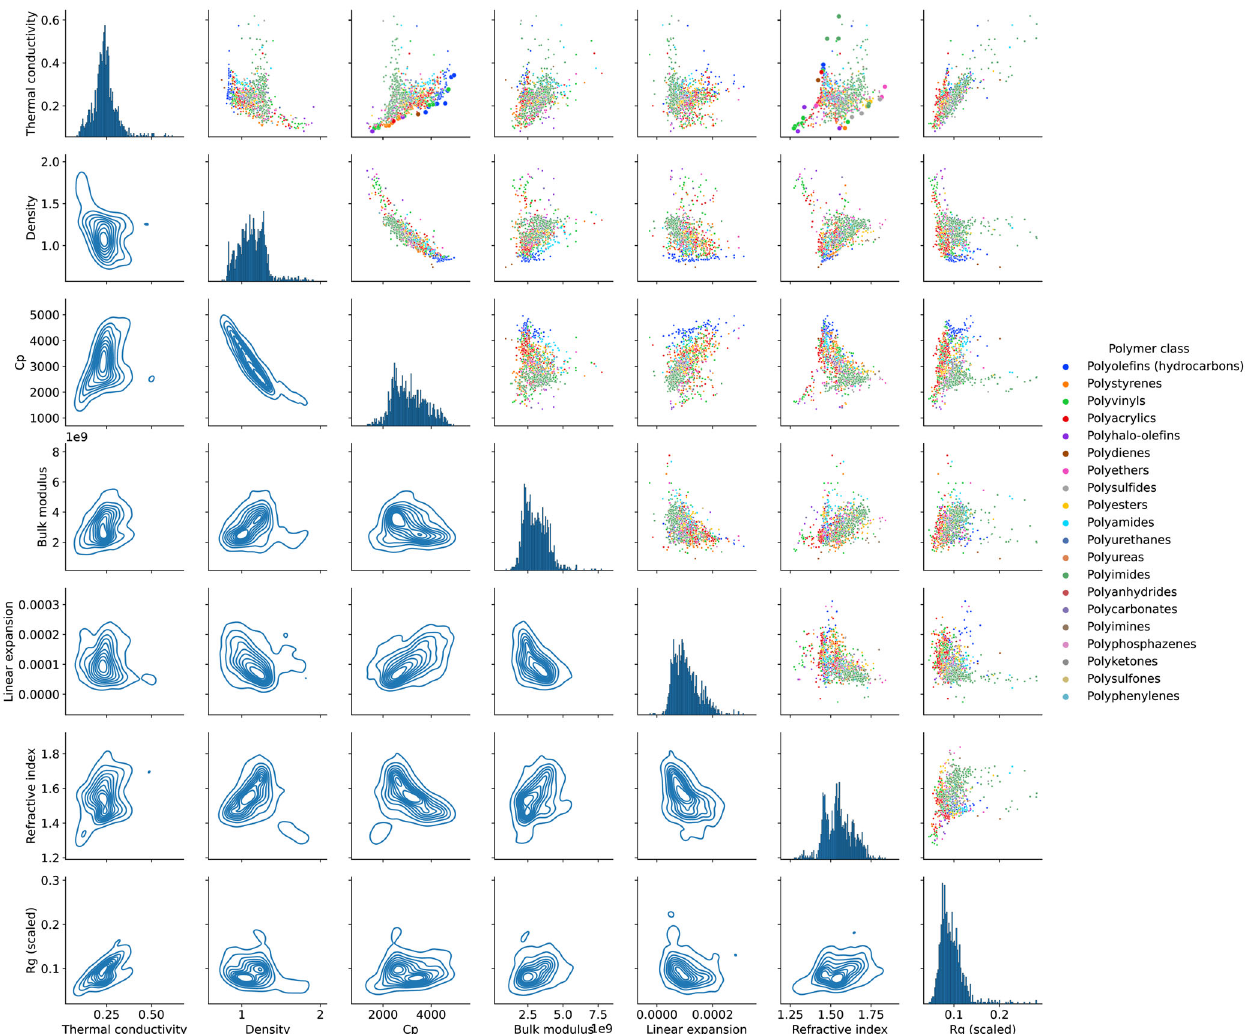
Fig. 4 Joint distribution of the six properties calculated from the automatic MD simulation, including the thermal conductivity (W ∙ m – 1 ∙ K – 1 ), density (g ∙ cm − 3 ), speci fi c heat capacity C P (J ∙ kg − 1 ∙ K − 1 ), bulk modulus (Pa), linear expansion coef fi cient (K − 1 ), refractive index, and radius of gyration Rg (scaled). The diagonal panels represent the histograms of the individual property values. In the upper off- diagonal panels, a scatter plot of each pair of properties is shown with its Pareto front set displayed as large dots that indicates higher and lower bounds of speci fi c heat capacity and thermal conductivity, refractive index and thermal conductivity, and thermal conductivity and refractive index. The lower off-diagonal panels represent the kernel density estimation of the bivariate joint distributions, which is displayed with